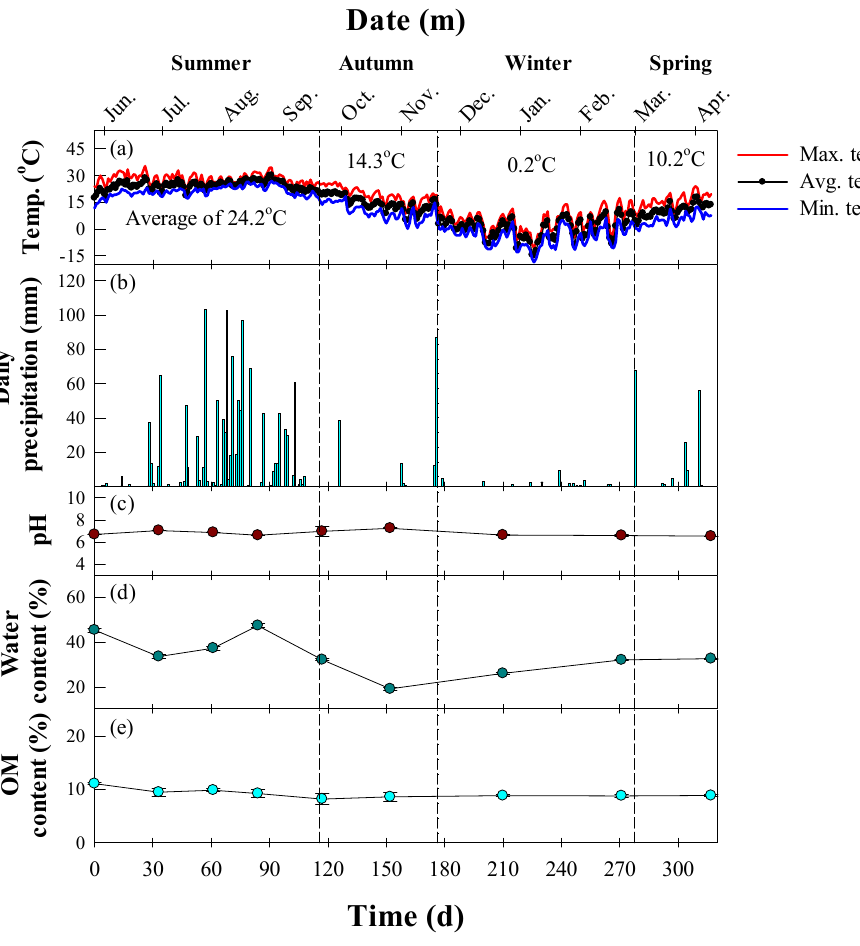
Figure 1. Time profile of the weather in Seoul, South Korea, and the physicochemical properties of the diesel-contaminated soil. ( a ) Ambient temperature and ( b ) daily precipitation in Seoul over the experimental period. ( c ) pH, ( d ) water content (%), and ( e ) organic matter content (%) of the soil.